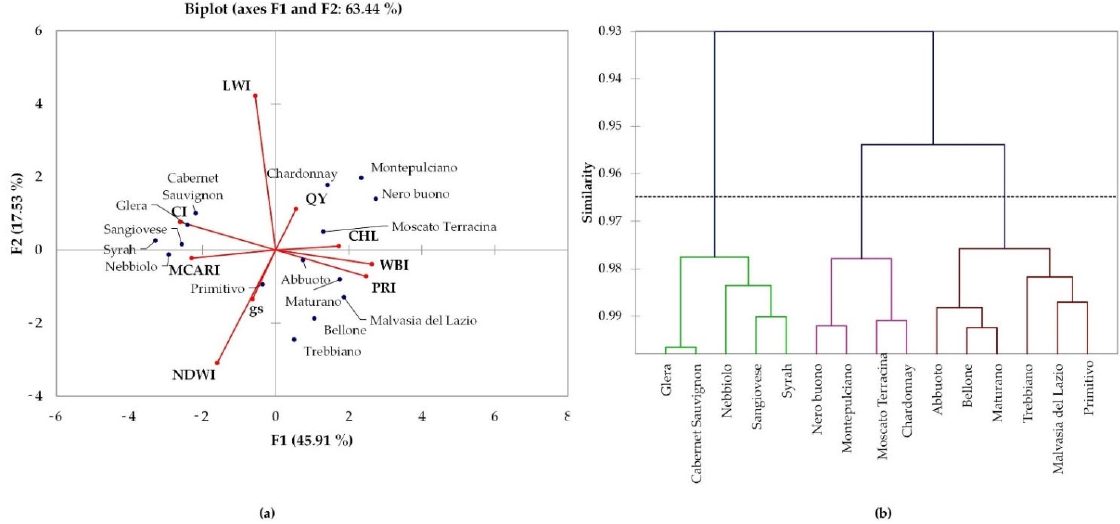
Figure 7. Principal component analysis (PCA) ( a ) and dendrogram of agglomerative hierarchical clustering (AHC) ( b ) obtained using physiological data for the 15 selected genotypes in the metropolitan area of Rome.